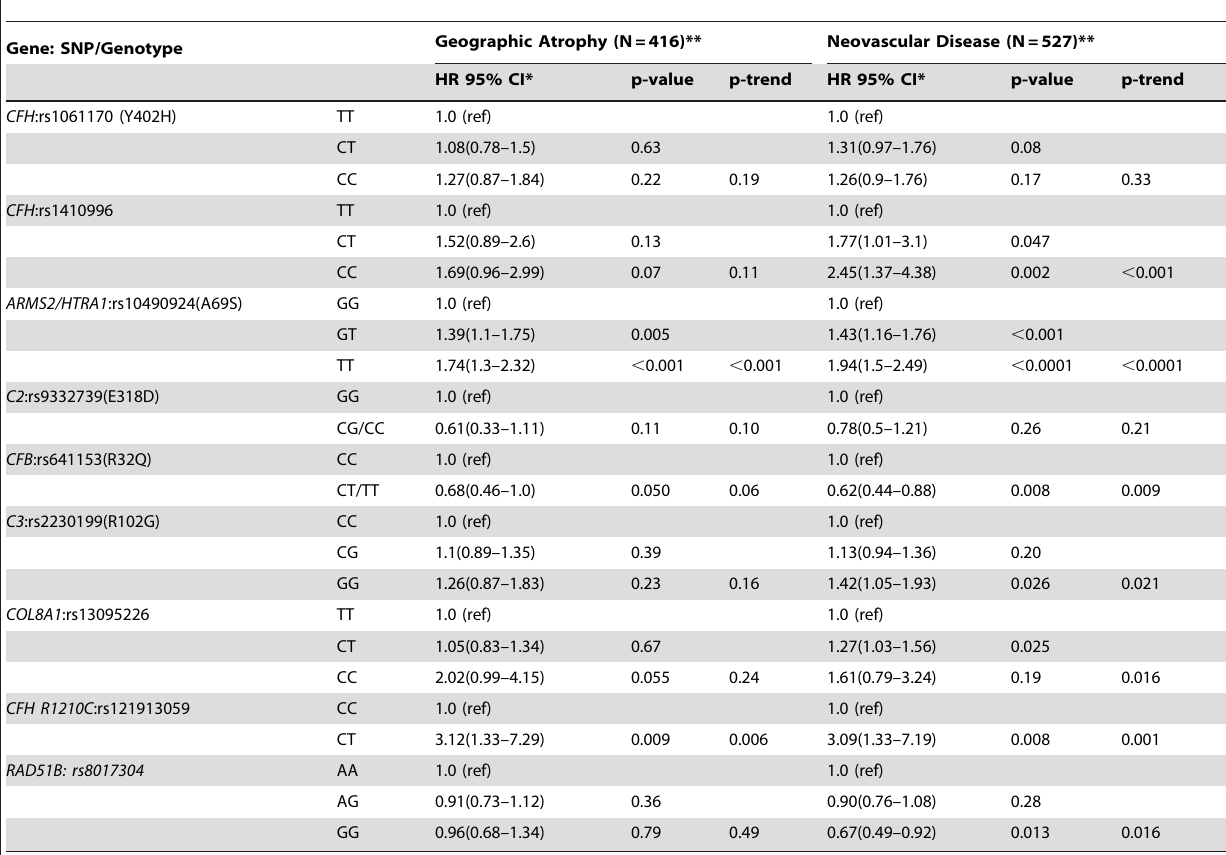
Table 5. 9 Gene Model for Geographic Atrophy and Neovascular Disease.